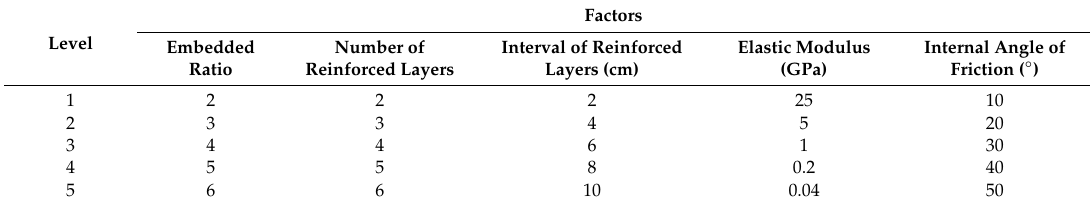
Table 6. The factor and the factor level.